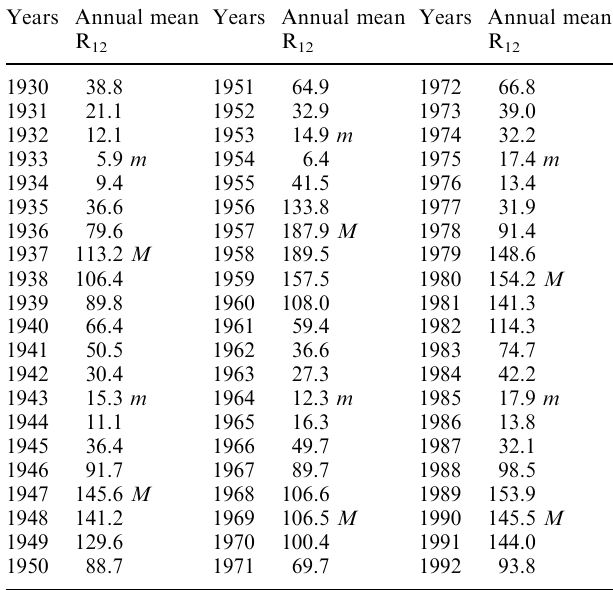
Table 1. Years of solar minimum ( m ) and maximum ( M ) used in the analysis Years Annual mean